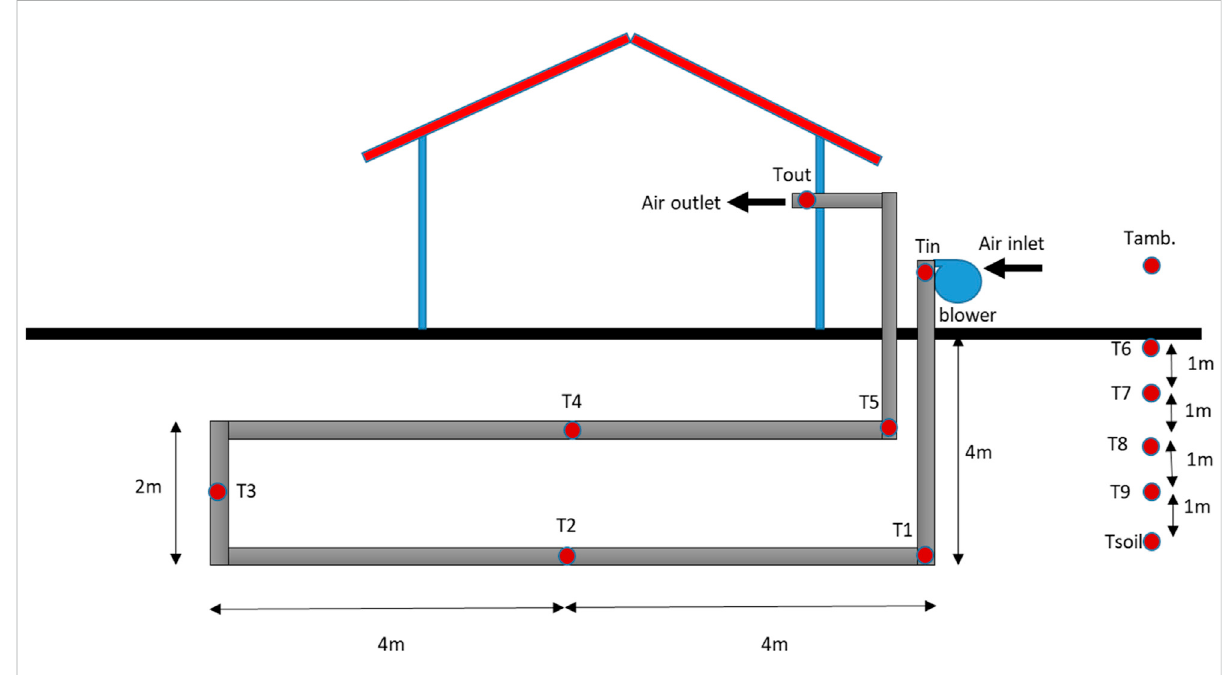
FIGURE 1 Schematic diagram of the experimental earth heat exchanger prototype.